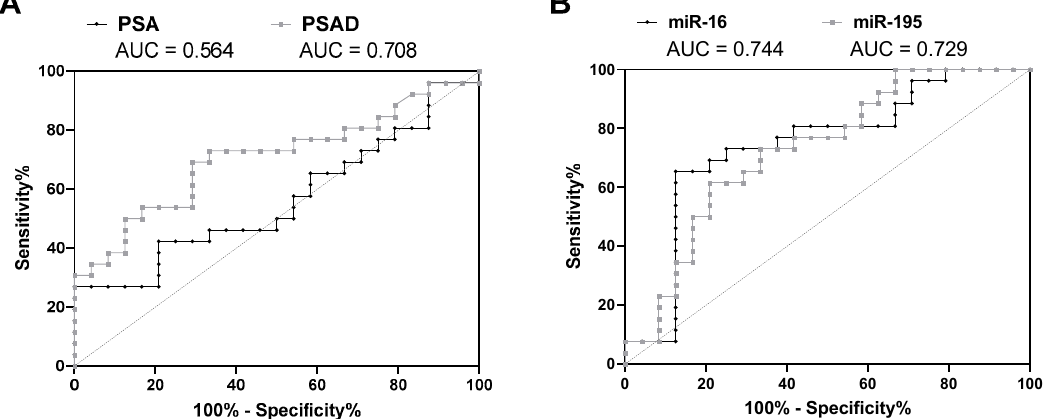
Figure 2. ROC curve analysis of ( A ) serum PSA levels and PSAD as well as of ( B ) miR-16 and miR-195 expression levels in urinary sediments using the whole study cohort ( n = 50).